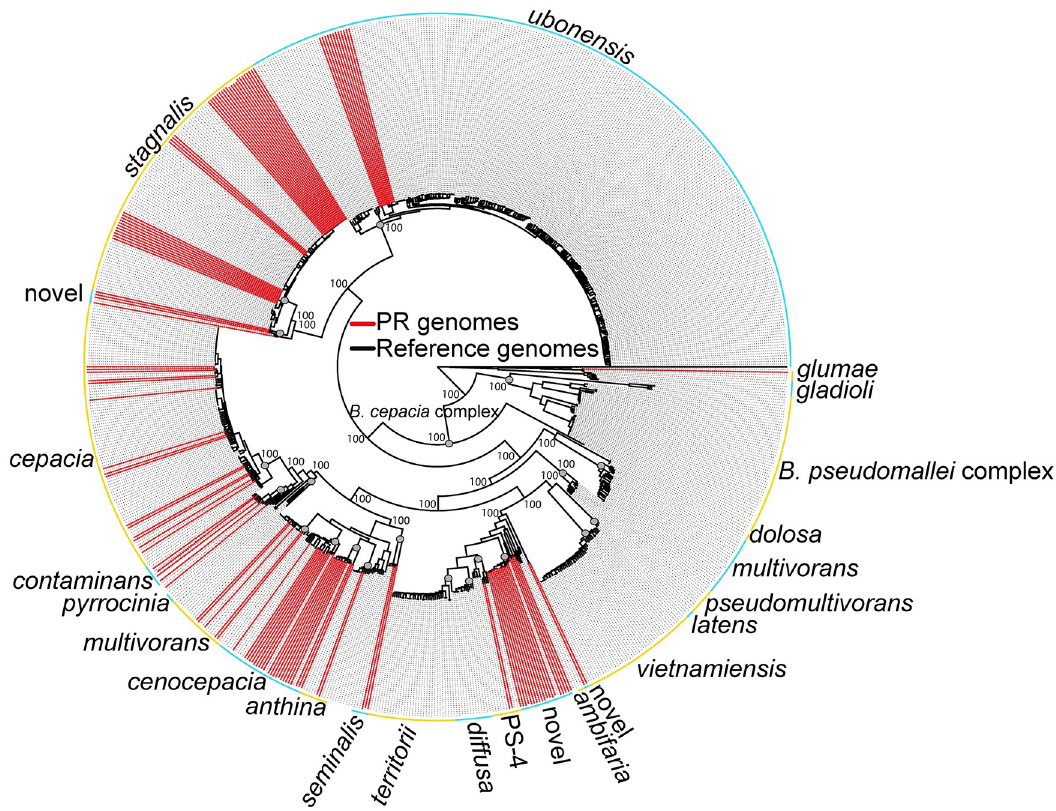
Fig 4. Burkholderia spp. whole genome phylogeny. Core genome maximum-likelihood phylogeny of 781 Burkholderia spp. isolates rooted with Cupriavidus . The 781 isolates include 129 isolates obtained from Puerto Rico in this study (indicated with red lines; S1 Table) and 651 publicly available Burkholderia spp. isolates (S5 Table). Bootstrap values are reported on